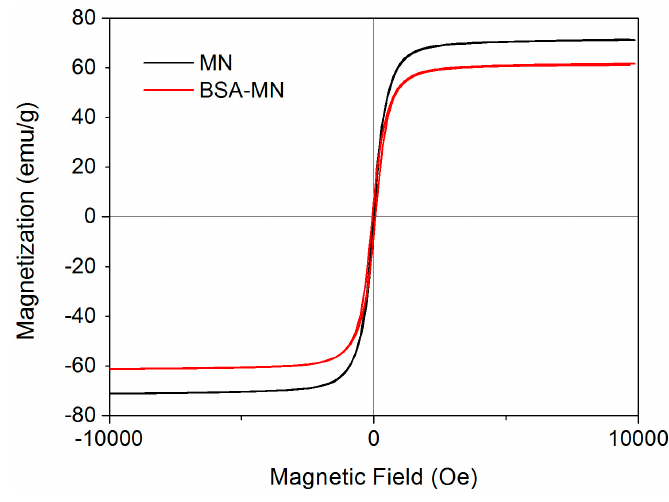
Figure 4. The magnetization curves of MN ( black ) and BSA-MN ( red ).